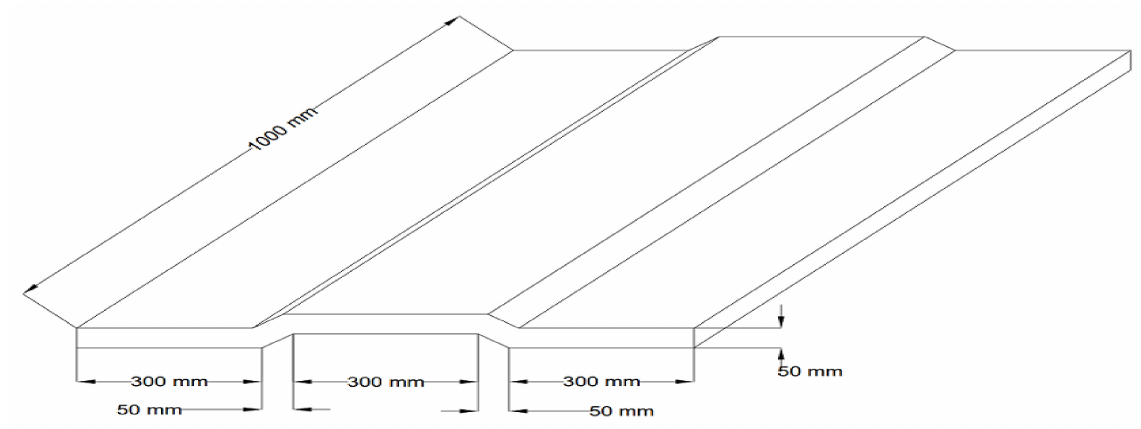
Figure 2. Geometry details of Ferrocement Panel.